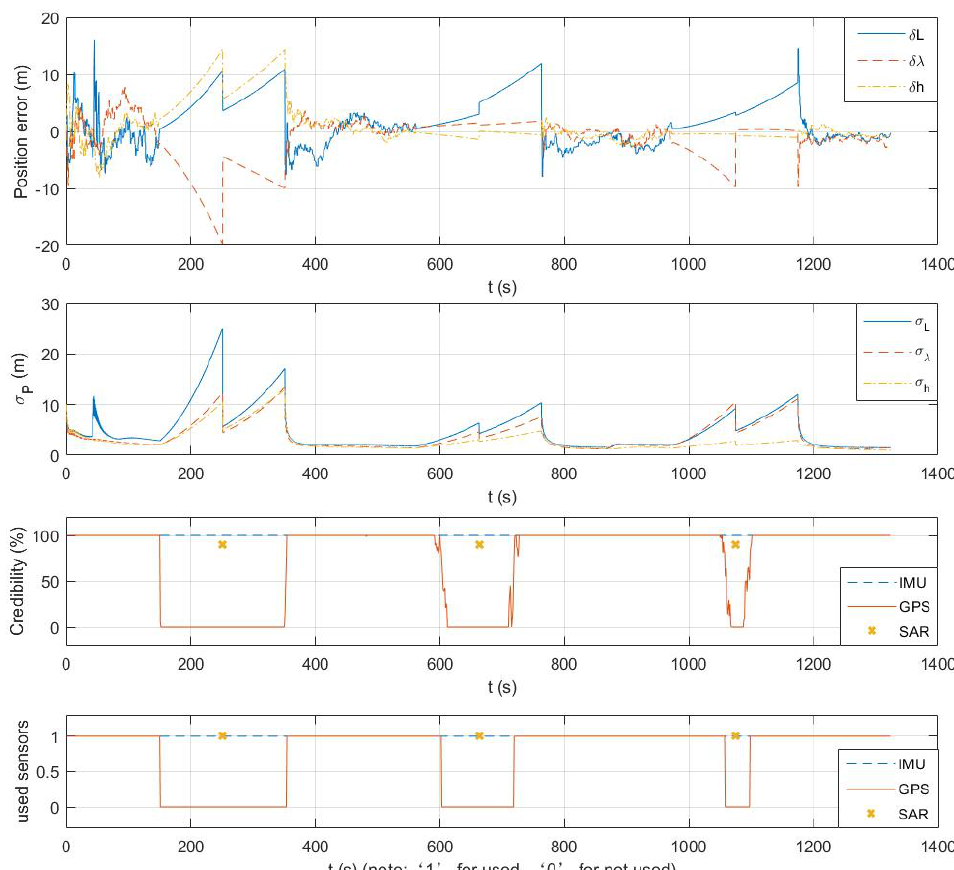
Figure 10. SINS/SAR/GPS position error and standard deviation with sensor credibility evaluation.